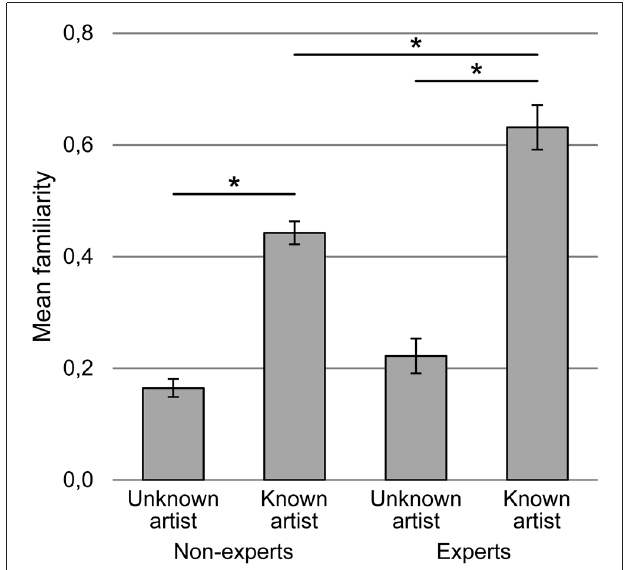
FIGURE 1 | The interaction of variables expertise and artist on familiarity of the painting. Vertical bars denote ± standard errors, ∗ means a significant